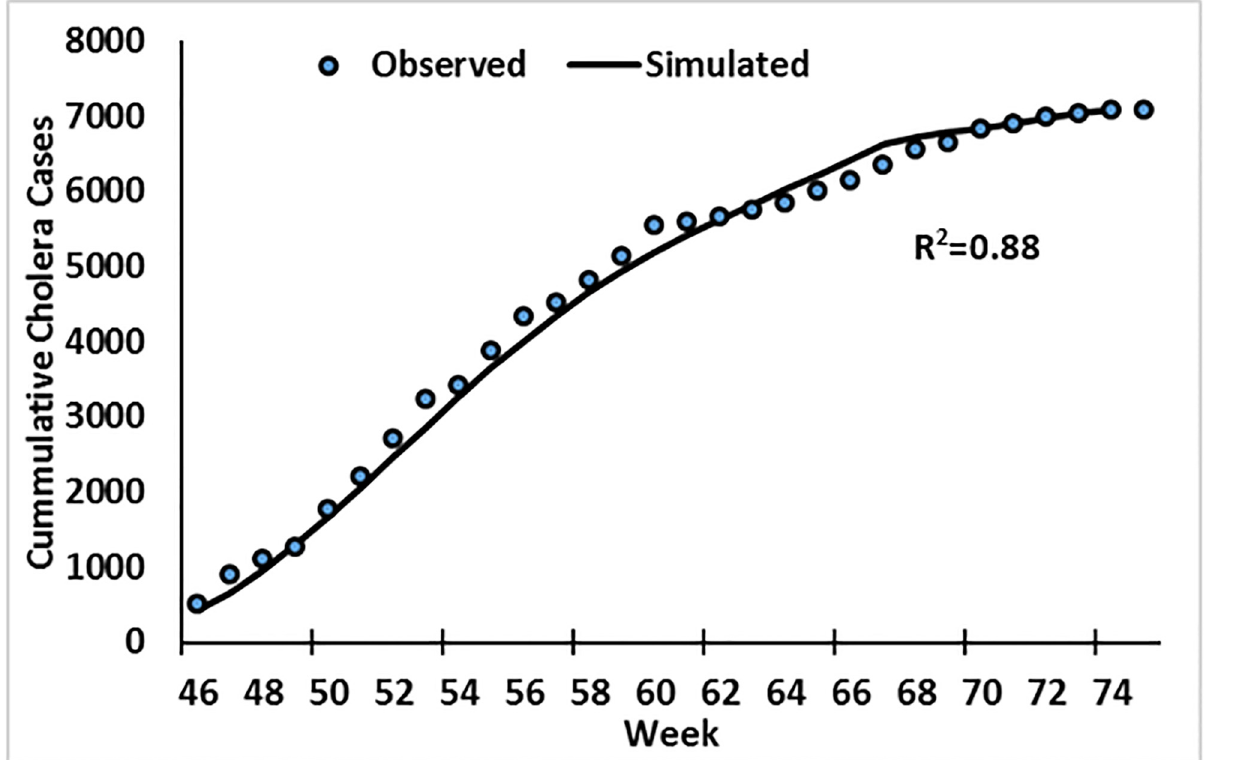
Fig 8. Calibration of the model using Mashonaland East cholera data. (Starting week 46 represent November 13, 2008).